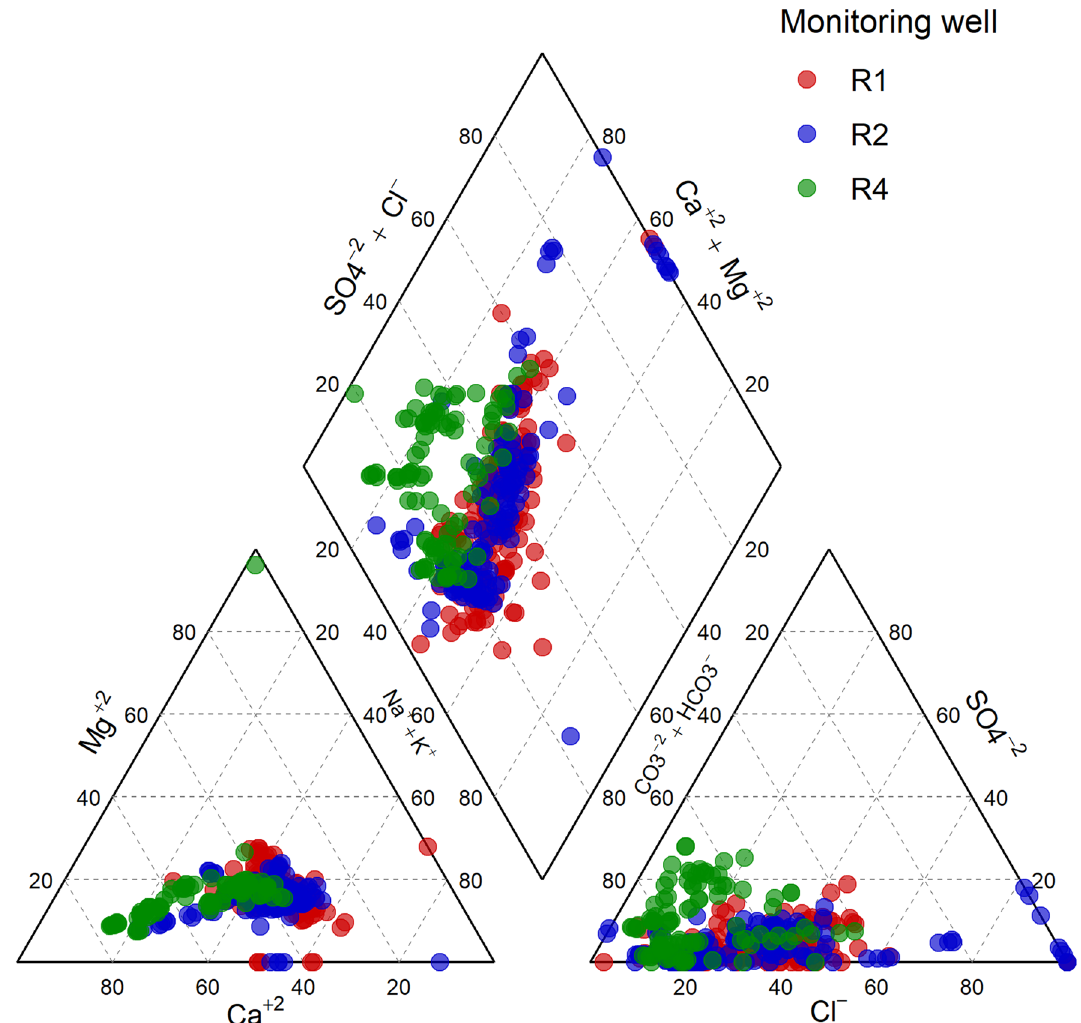
Figure 4. Characteristics of groundwater chemistry based on levels (% meq/l) of calcium, magnesium, potassium, sodium, chloride, sulphate and bicarbonate from the monitoring wells R1, R2 and R4. The wells were placed along the groundwater flow direction in an increasing distance from the edge of the